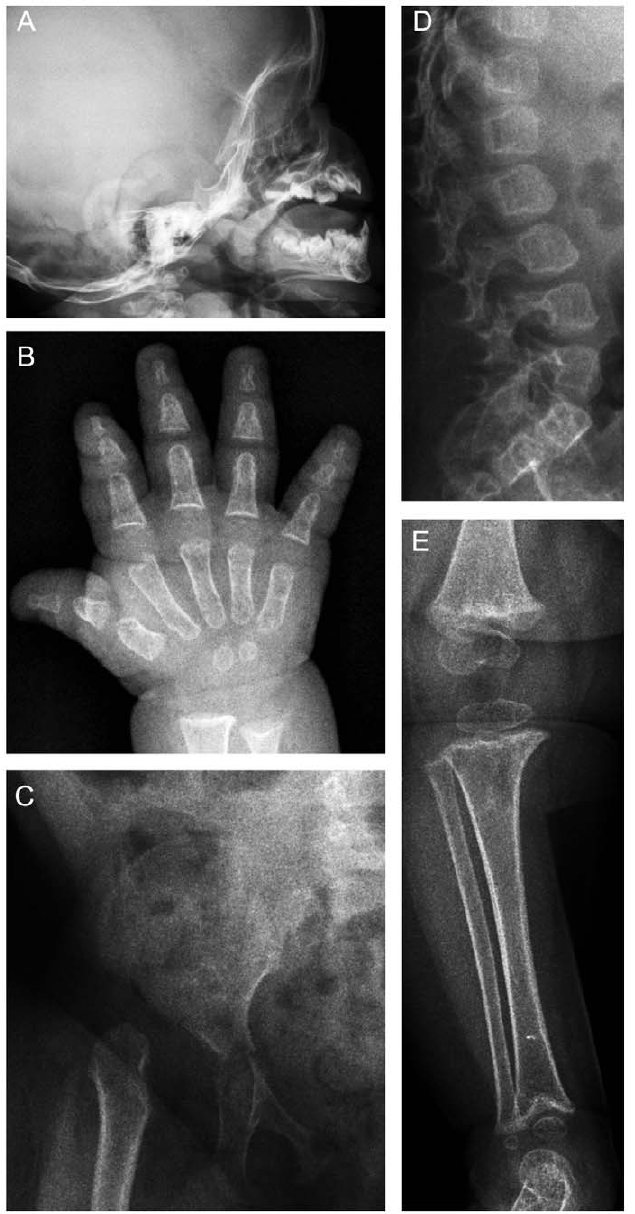
Figure 1. Radiographs of patient 1 at 13 months of age. (A) J-shaped sella. (B) The tubular bones in the hand are short and show metaphyseal irregularities. (C) The iliac bodies are hypoplastic with slanting acetabular roofs. The capital femoral epiphyses are unossified and the femoral necks are hypoplastic and in varus position. The pubic bones are thin. (D) The vertebral bodies are ovoid with dorsal wedging. (E) Metaphyseal irregularities at the knee and ankle, the metaphysis of the distal tibia is